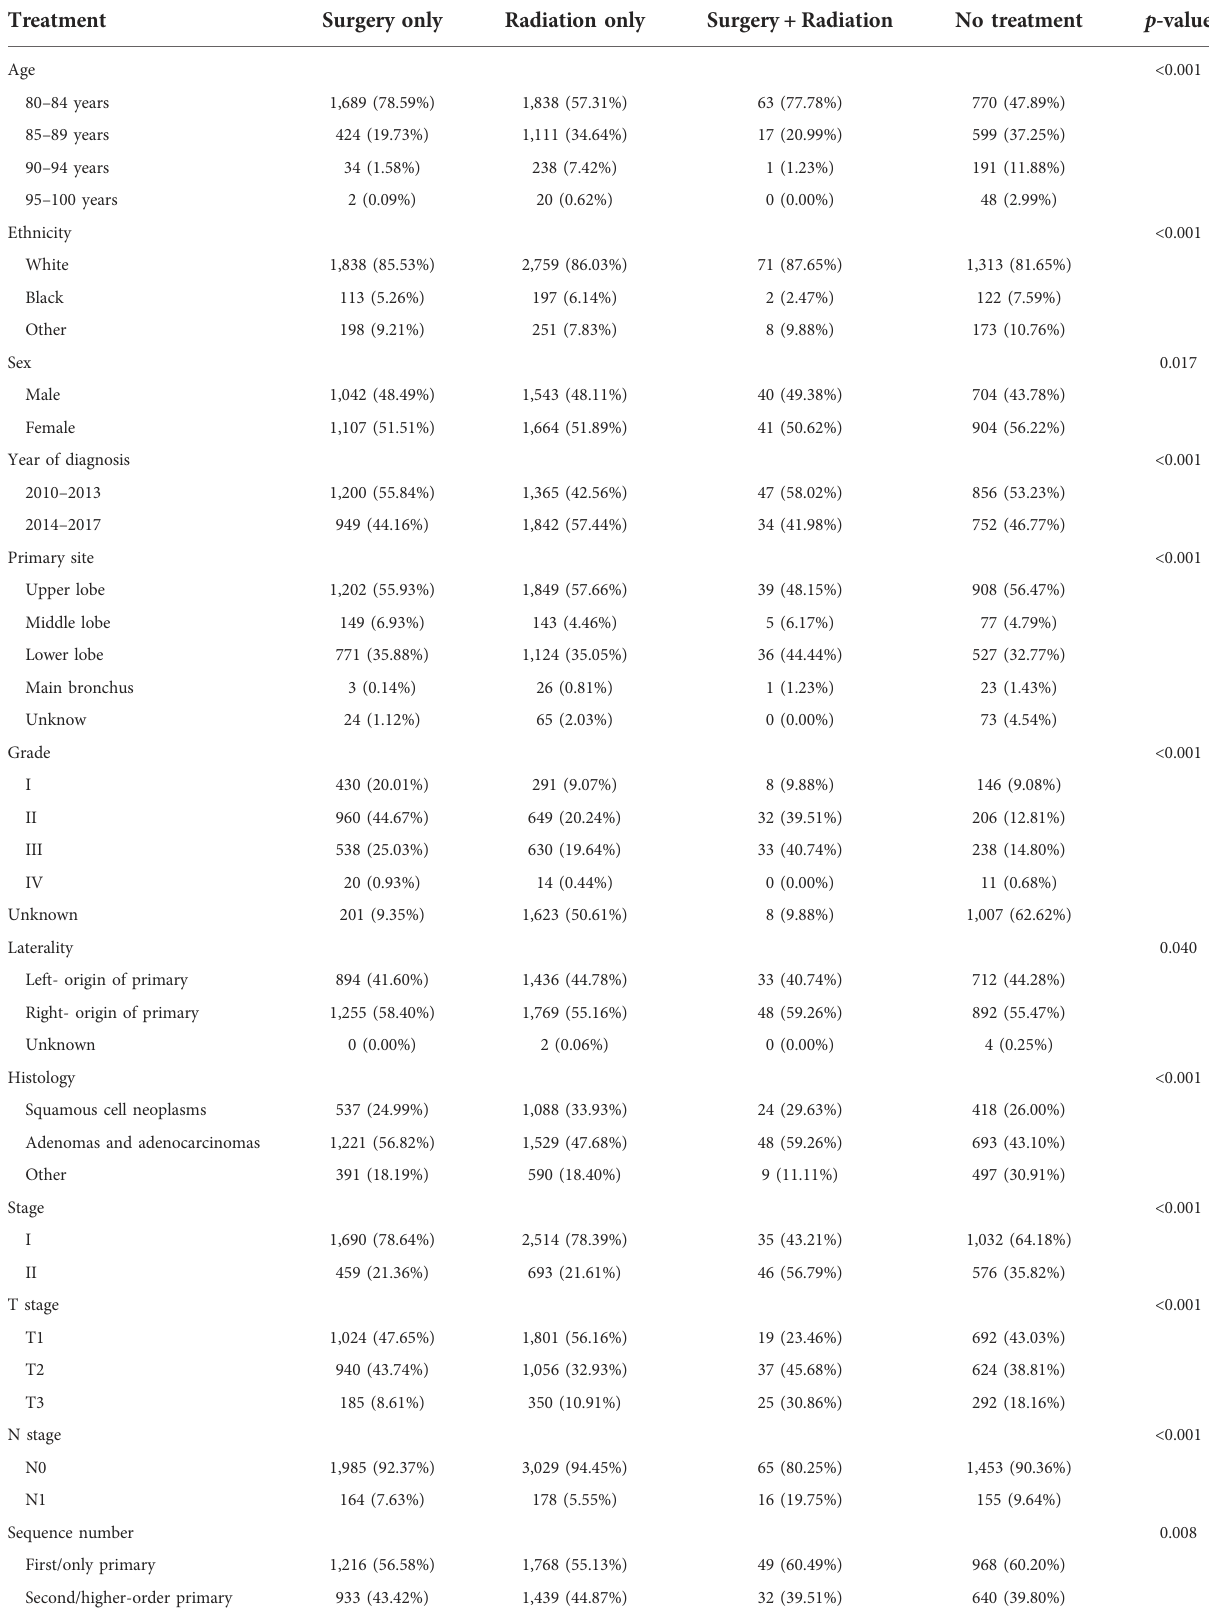
TABLE 1 Baseline characteristics of the study participants by treatment